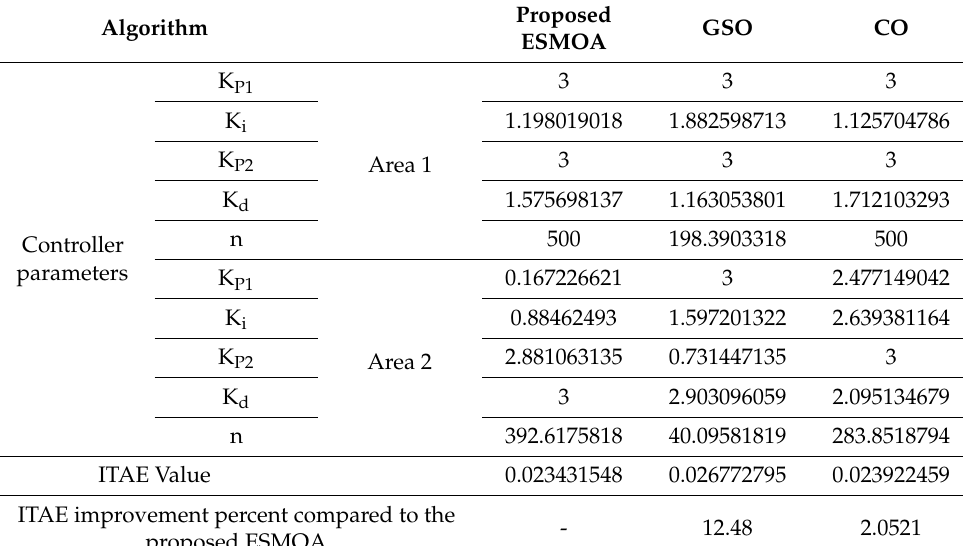
Table 3. Results for Case